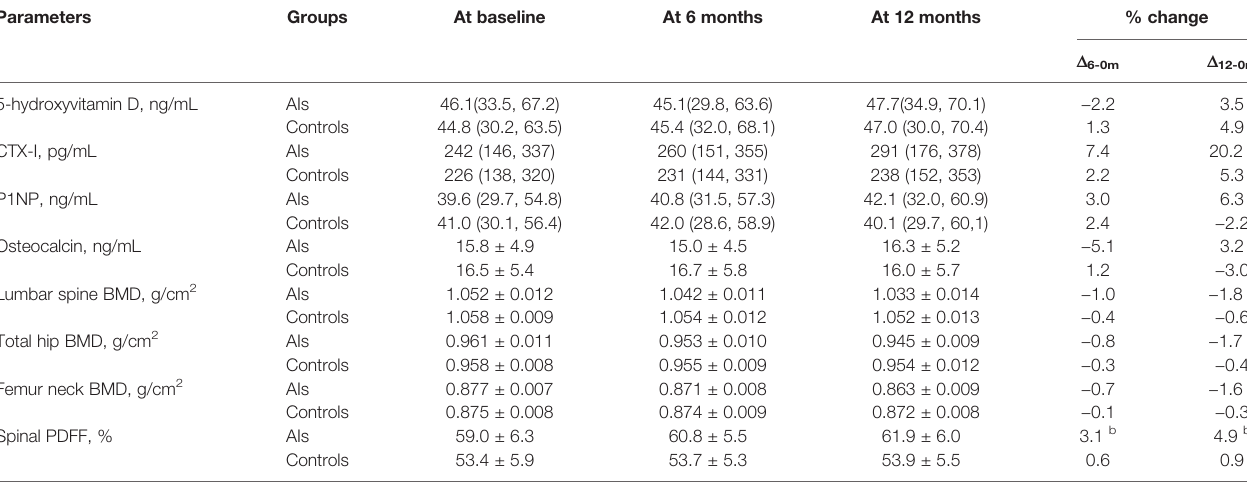
Frontiers in Endocrinology |